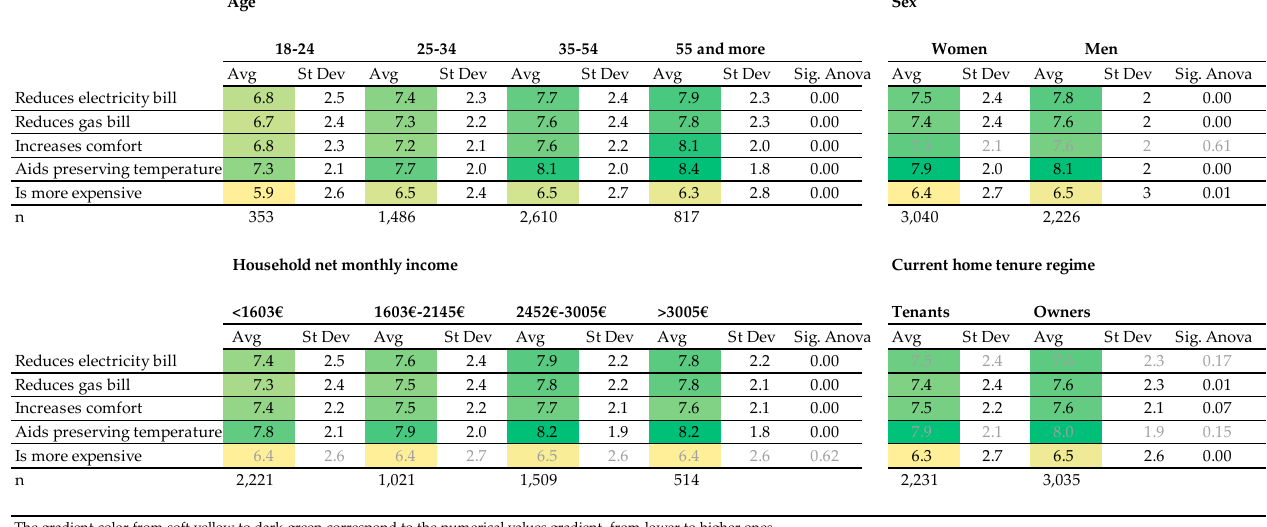
The gradient color from soft yellow to dark green correspond to the numerical values gradient, from lower to higher ones. Figure 5. Perceived co-benefits according to respondents’ sociodemographic profile. Source: Self elaboration.